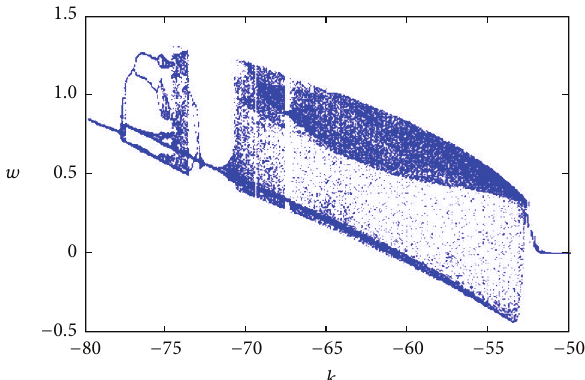
Figure 6: Bifurcation diagram for −80 < 𝑘 < −50 .